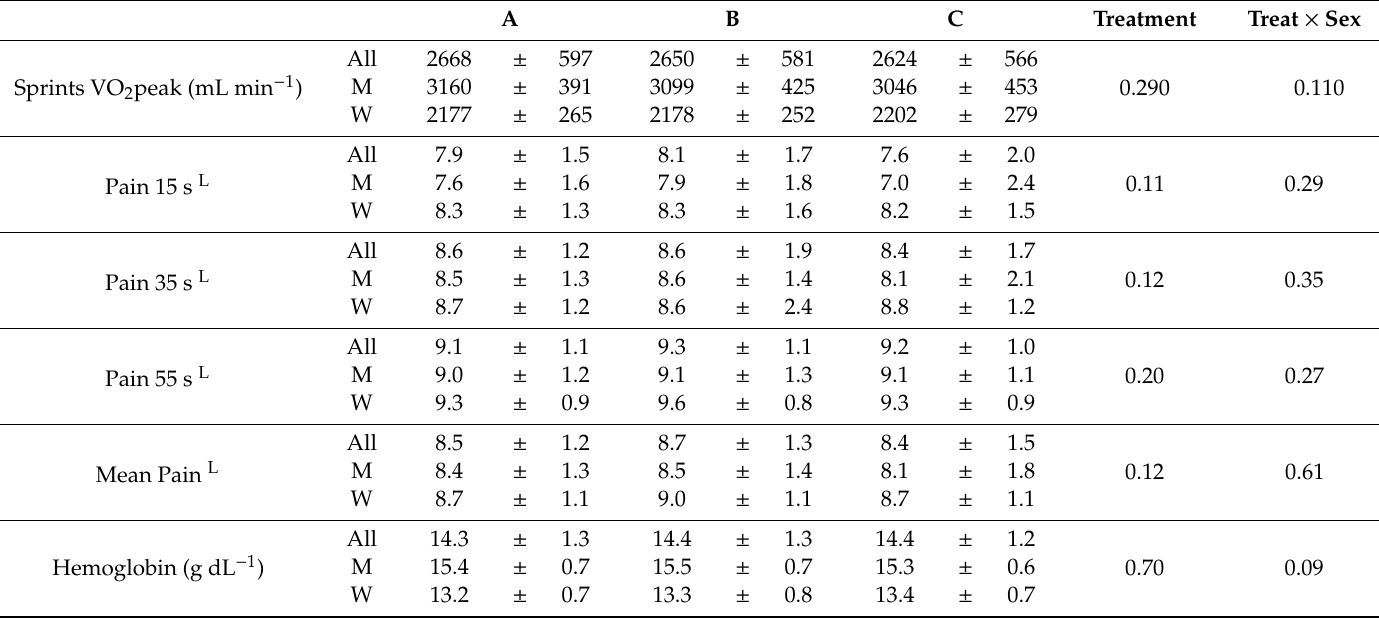
Table 4. Peak VO 2 during the sprints, pain felt during the 60 s occlusions and hemoglobin concentration before the sprints (mean ±